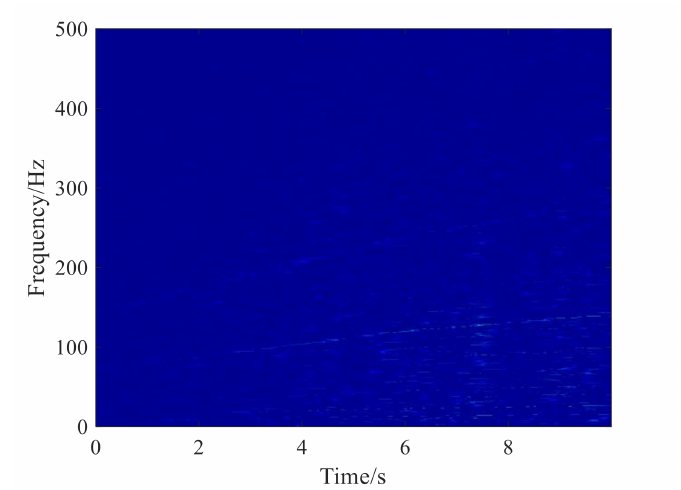
Figure 17. The result provided by Synchroextracting Transform (SET).